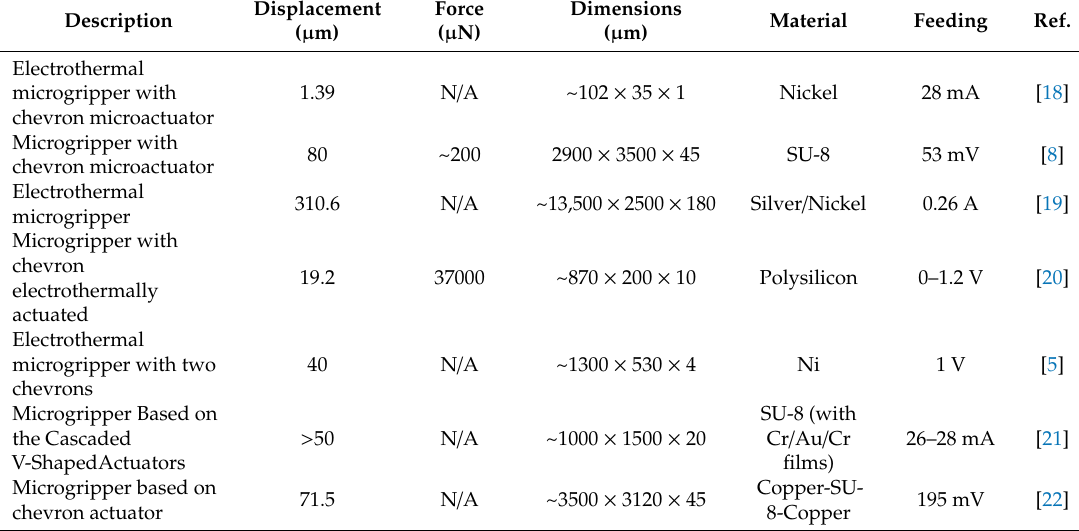
Table 1. State of the art of advances in microgrippers actuated by chevron actuators. Description